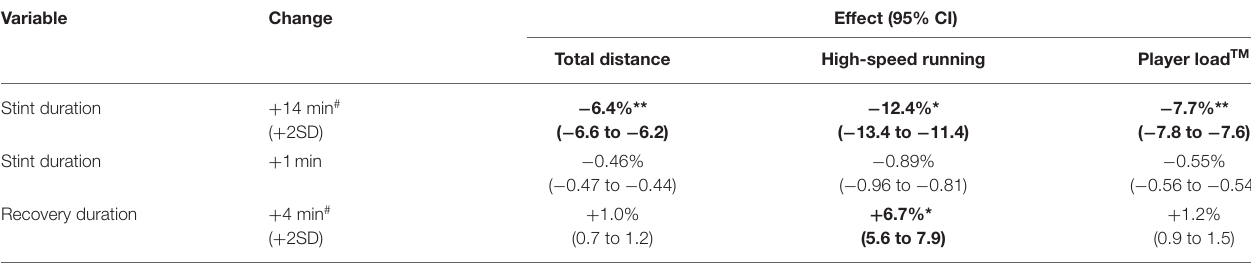
TABLE 3 | The effects of stint duration and recovery duration (between-stints bench time). Variable